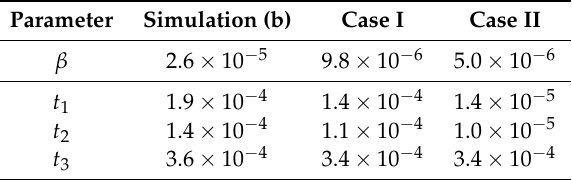
Table 6. Comparison of the 1- σ accuracies achievable for the torsion parameters, setting